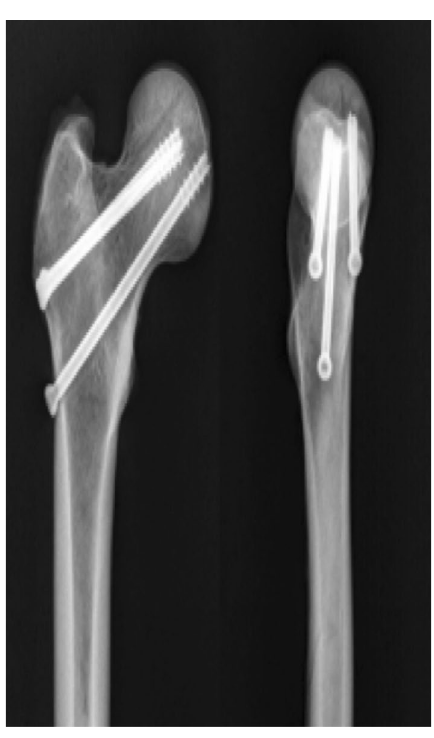
Figure 3. Three cannulated compression screws (3CCS) ( Note : Positive and lateral X-ray film after internal